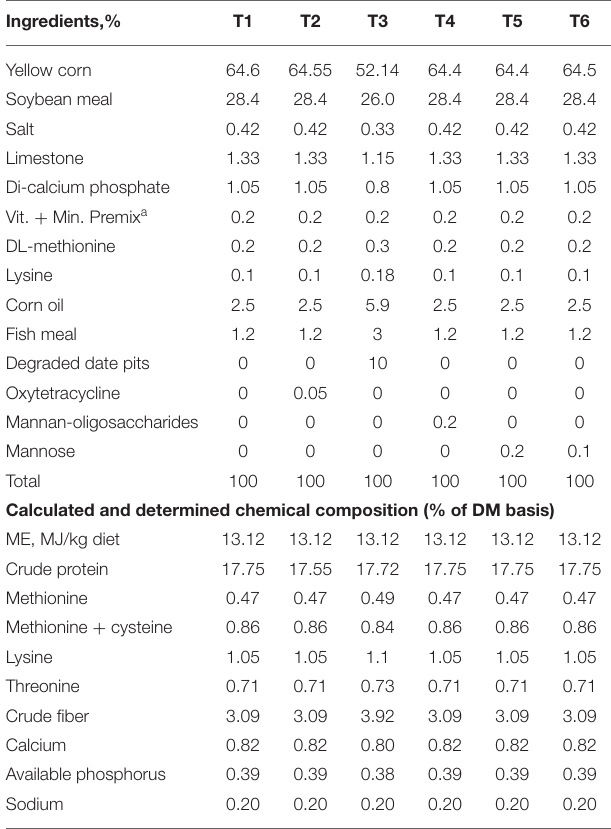
TABLE 2 | Composition and calculated chemical analysis of experimental finisher diets on dry matter basis for broilers. Ingredients,%